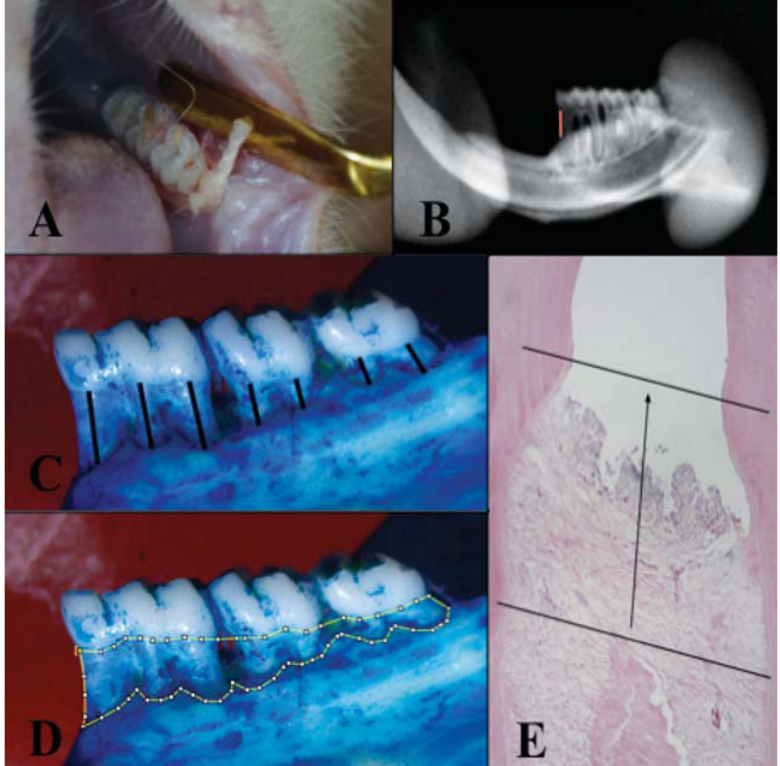
Figure 1- (cid:3)(cid:11)(cid:36)(cid:12)(cid:3)(cid:47)(cid:76)(cid:74)(cid:68)(cid:87)(cid:88)(cid:85)(cid:72)(cid:16)(cid:76)(cid:81)(cid:71)(cid:88)(cid:70)(cid:72)(cid:71)(cid:3)(cid:83)(cid:72)(cid:85)(cid:76)(cid:82)(cid:71)(cid:82)(cid:81)(cid:87)(cid:76)(cid:87)(cid:76)(cid:86)(cid:3)(cid:80)(cid:72)(cid:87)(cid:75)(cid:82)(cid:71)(cid:82)(cid:79)(cid:82)(cid:74)(cid:92)(cid:30)(cid:3)(cid:11)(cid:37)(cid:12)(cid:3)(cid:83)(cid:68)(cid:85)(cid:68)(cid:80)(cid:72)(cid:87)(cid:72)(cid:85)(cid:86)(cid:3)(cid:88)(cid:86)(cid:72)(cid:71)(cid:3)(cid:73)(cid:82)(cid:85)(cid:3)(cid:85)(cid:68)(cid:71)(cid:76)(cid:82)(cid:74)(cid:85)(cid:68)(cid:83)(cid:75)(cid:76)(cid:70)(cid:3)(cid:80)(cid:72)(cid:68)(cid:86)(cid:88)(cid:85)(cid:72)(cid:80)(cid:72)(cid:81)(cid:87)(cid:3)(cid:11)(cid:80)(cid:80)(cid:12)(cid:30)(cid:3)(cid:11)(cid:38)(cid:12)(cid:3)(cid:83)(cid:68)(cid:85)(cid:68)(cid:80)(cid:72)(cid:87)(cid:72)(cid:85)(cid:86)(cid:3)(cid:88)(cid:86)(cid:72)(cid:71)(cid:3) (cid:73)(cid:82)(cid:85)(cid:3)(cid:80)(cid:82)(cid:85)(cid:83)(cid:75)(cid:82)(cid:80)(cid:72)(cid:87)(cid:85)(cid:76)(cid:70)(cid:3)(cid:11)(cid:79)(cid:76)(cid:81)(cid:72)(cid:68)(cid:85)(cid:15)(cid:3)(cid:80)(cid:80)(cid:12)(cid:3)(cid:80)(cid:72)(cid:68)(cid:86)(cid:88)(cid:85)(cid:72)(cid:80)(cid:72)(cid:81)(cid:87)(cid:30)(cid:3)(cid:11)(cid:39)(cid:12)(cid:3)(cid:83)(cid:68)(cid:85)(cid:68)(cid:80)(cid:72)(cid:87)(cid:72)(cid:85)(cid:86)(cid:3)(cid:88)(cid:86)(cid:72)(cid:71)(cid:3)(cid:73)(cid:82)(cid:85)(cid:3)(cid:80)(cid:82)(cid:85)(cid:83)(cid:75)(cid:82)(cid:80)(cid:72)(cid:87)(cid:85)(cid:76)(cid:70)(cid:3)(cid:11)(cid:68)(cid:85)(cid:72)(cid:68)(cid:15)(cid:3)(cid:80)(cid:80) 2 (cid:12)(cid:3)(cid:80)(cid:72)(cid:68)(cid:86)(cid:88)(cid:85)(cid:72)(cid:80)(cid:72)(cid:81)(cid:87)(cid:30)(cid:3)(cid:68)(cid:81)(cid:71)(cid:3)(cid:11)(cid:40)(cid:12)(cid:3)(cid:83)(cid:68)(cid:85)(cid:68)(cid:80)(cid:72)(cid:87)(cid:72)(cid:85)(cid:86)(cid:3)(cid:88)(cid:86)(cid:72)(cid:71)(cid:3) for histological measurement